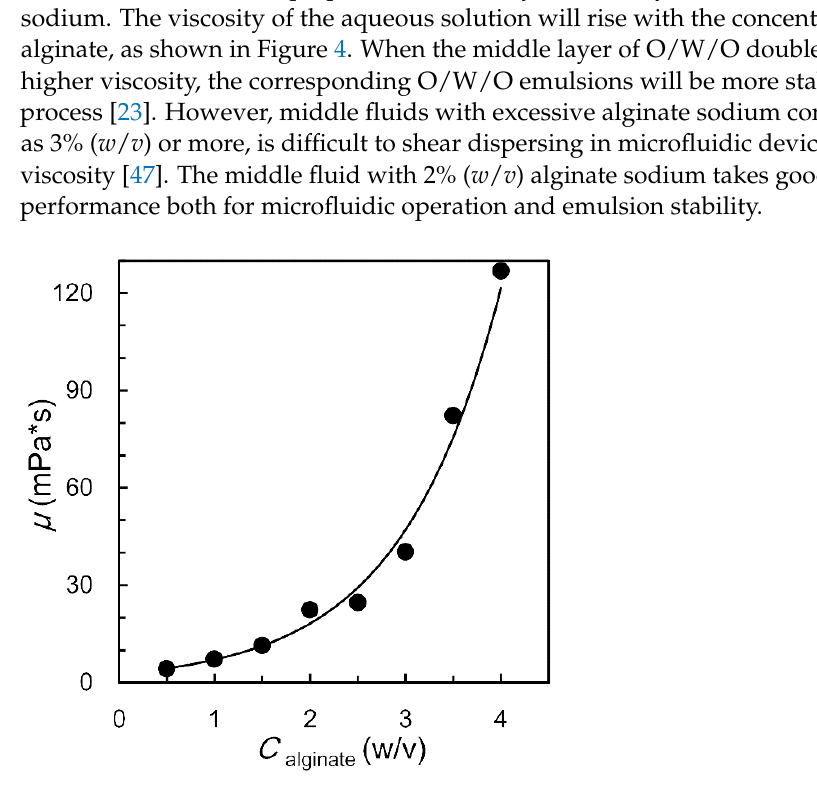
Figure 4. The viscosity of the aqueous solution with different sodium alginate content.